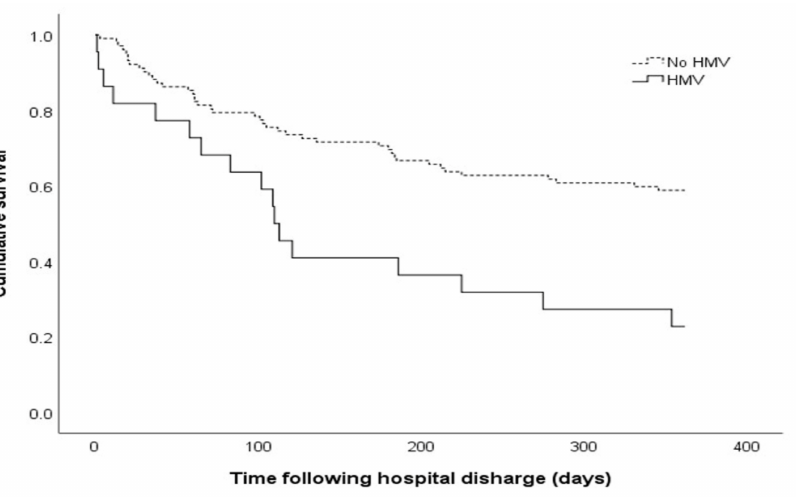
Figure 2. The Kaplan-Meier curve of the one-year survival plots comparing the no HMV group and the HMV group. The one-year survival rates were significantly lower for the HMV group than for the no HMV group (22.7% vs. 58.8%, p value = 0.001, Log Rank (Mantel-Cox)). HMV, home mechanical